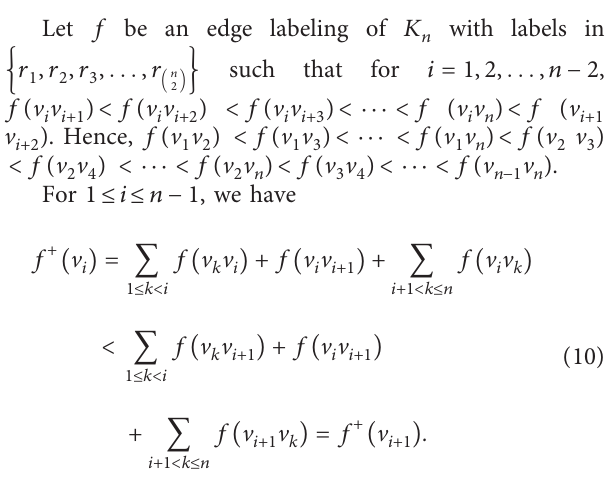
+ r ≤ r n − n . 2 n − 1 1